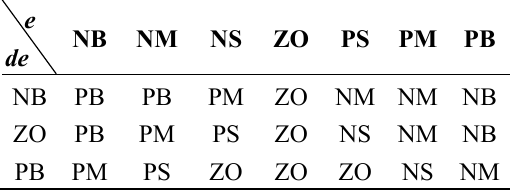
Table 1. A motor encoder compensation rule table.